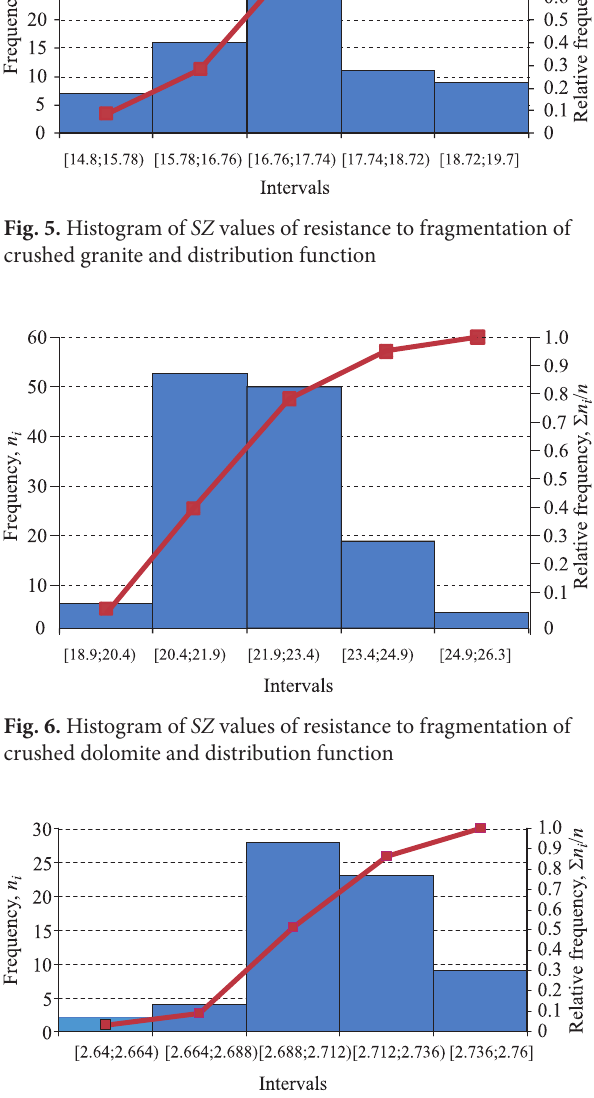
Fig. 7. Histogram of dry density ρ rd of crushed granite (fr. 8/12.5 mm) and distribution function